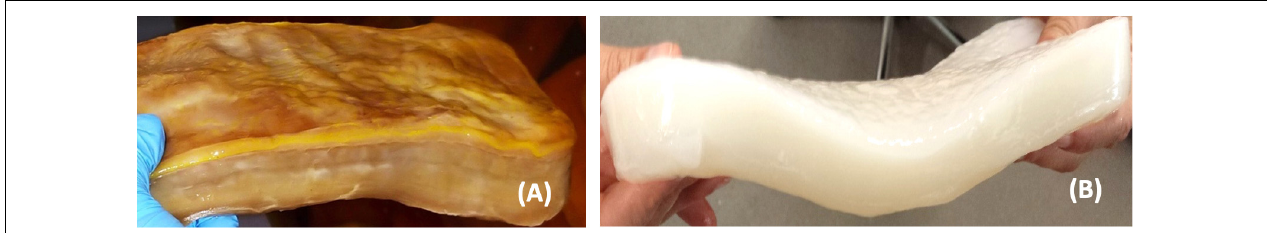
FIGURE 2 | BNC membrane before (A) and after (B)